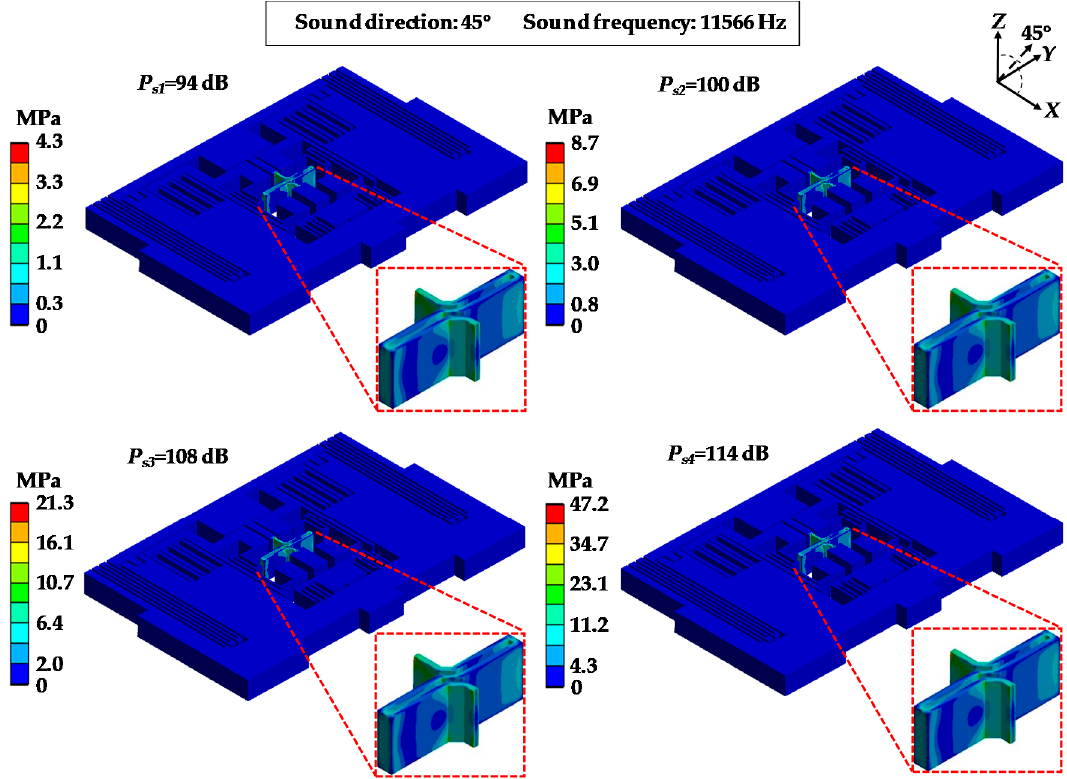
Figure 10. Equivalent stress distributions of MPU6050-Y under acoustic injection of different sound pressures.